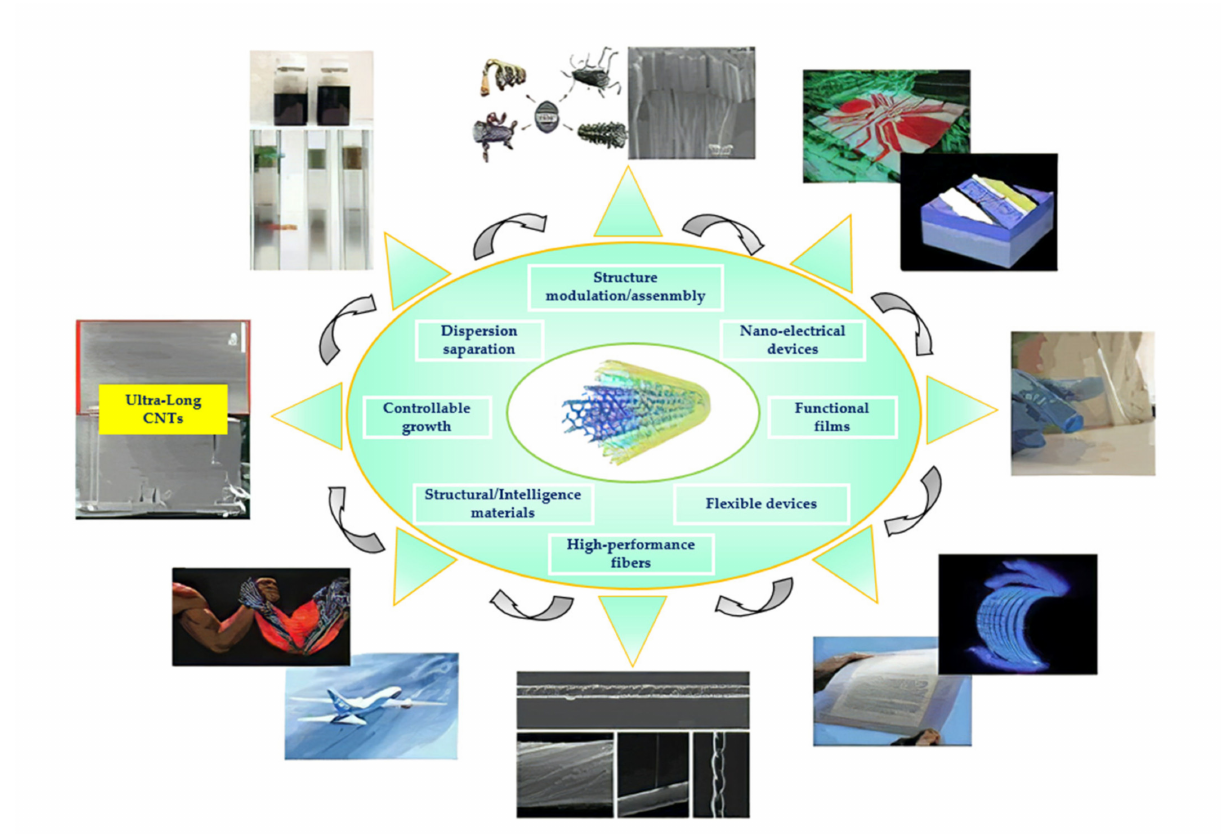
Figure 1. Various applications of